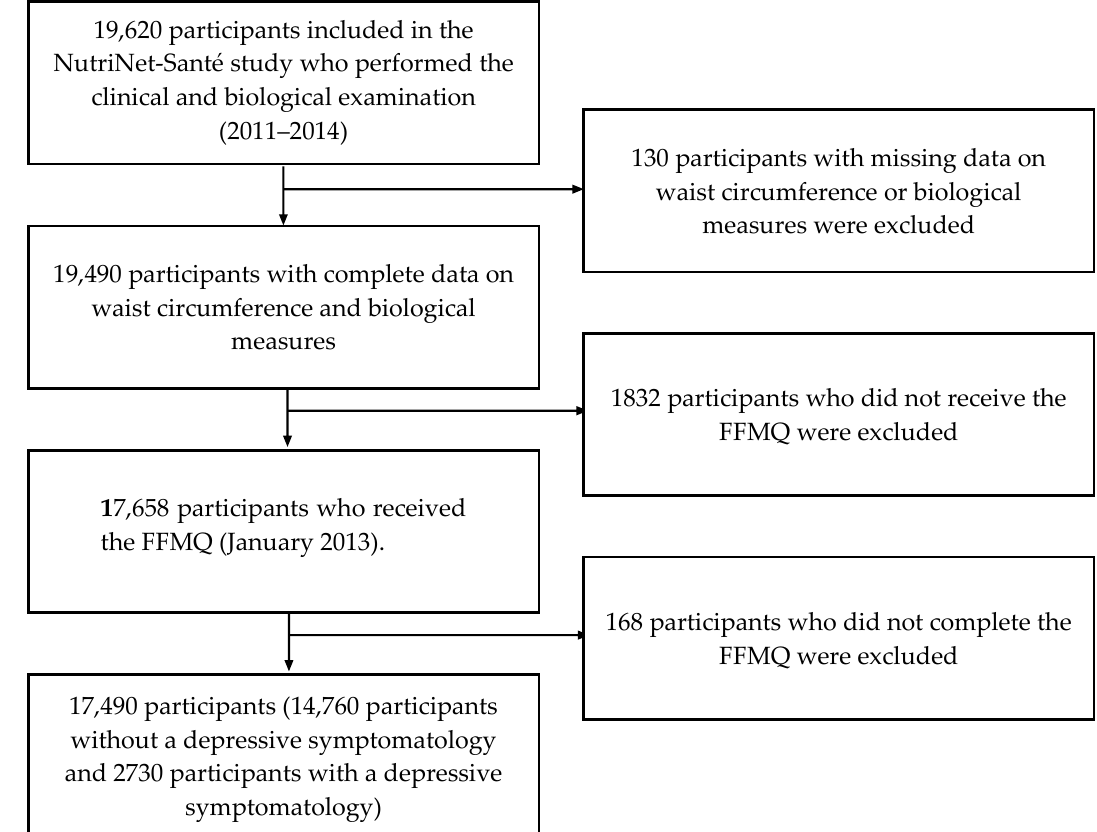
Figure 1. Flow chart for the participants from the NutriNet-Santé cohort study (2011–2014) included in the current analysis.